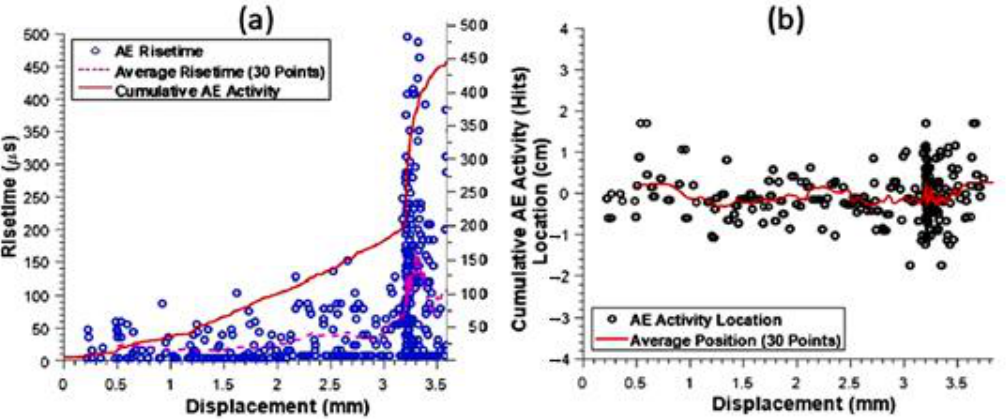
Figure 5. ( a ) Risetime and cumulative AE activity and ( b ) the location of AE events in the specimen during the static test [9].